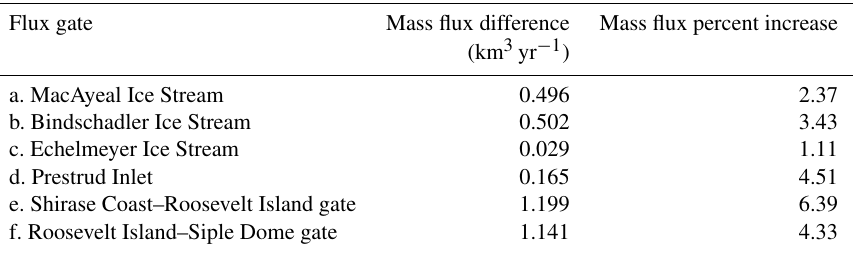
Table 3. Mass flux differences between the reference (with SCIR) and perturbed (no SCIR) models. The percent increase is the total mass flux increase in response to removal of the SCIR. Flux gate locations are shown in Fig.